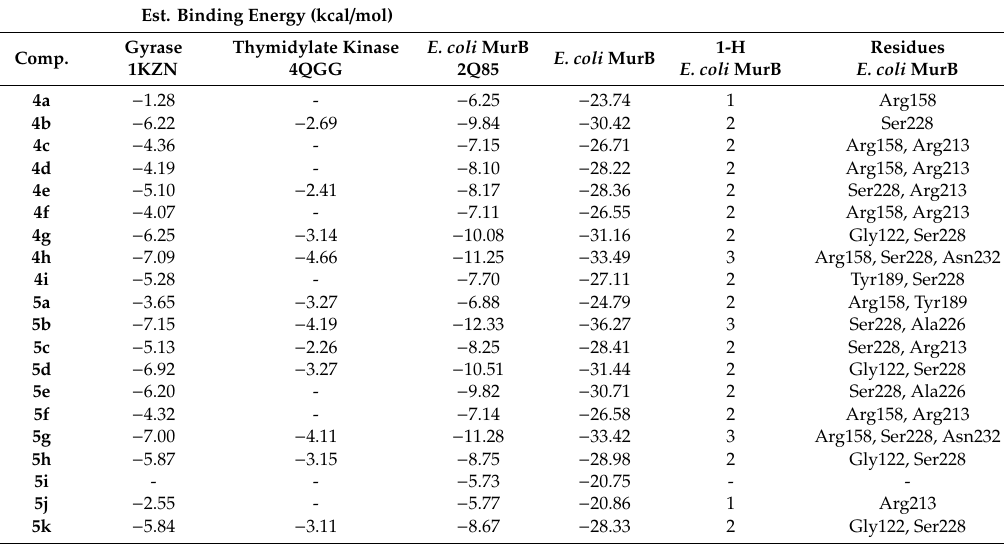
Table 4. Molecular docking binding a ffi nities on antibacterial